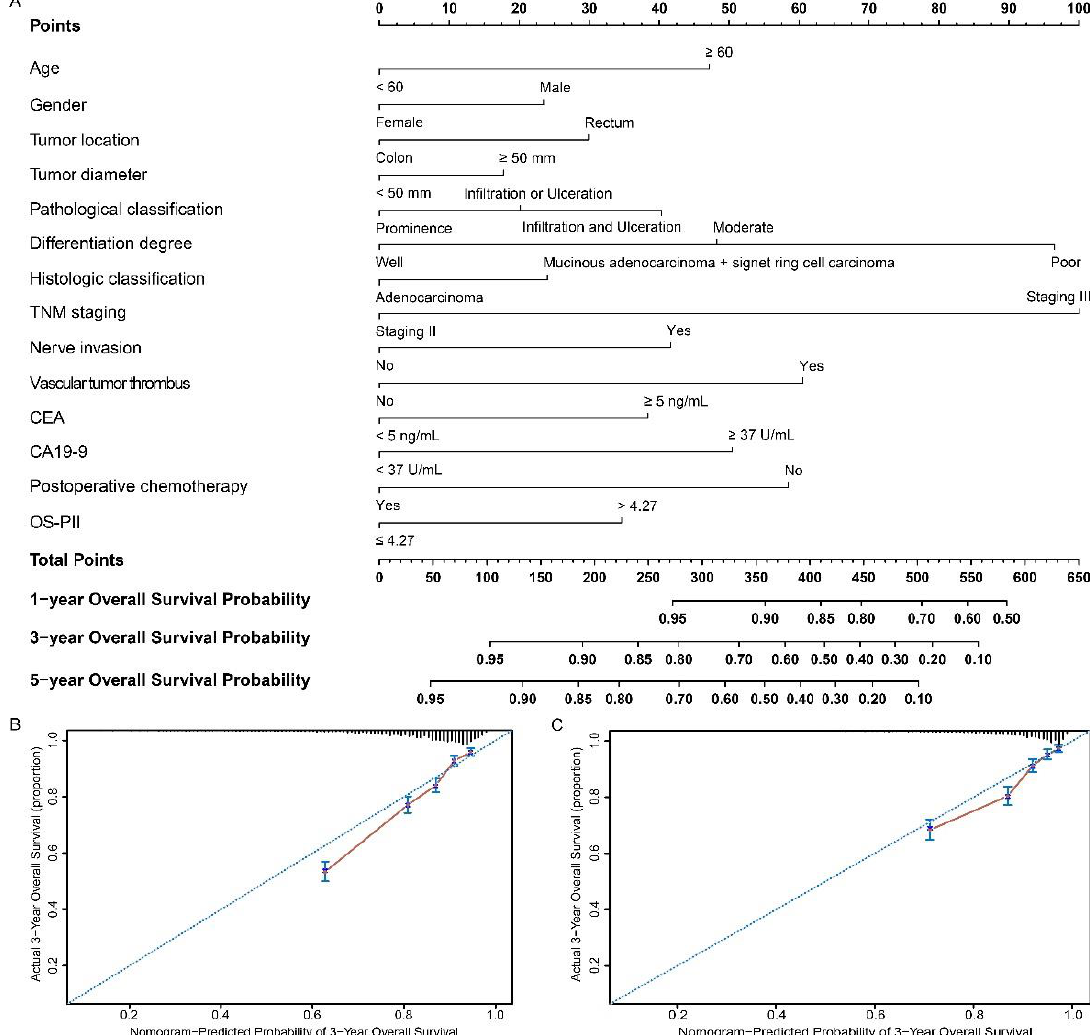
Figure 4. Nomograms to predict overall survival in patients with CRC. Nomograms were performed by using clinicopathological characteristics and OS-PII to predict overall survival ( A ) and calibration curves of the nomogram to predict overall survival at 3 years in the training cohort ( B ) and the validation cohort ( C ). Nomograms map the predicted probabilities onto points on a scale from 0 to 100 and can be interpreted by accumulating the points that correspond to the predicted probability, which is indicated at the top of scale. The total points were converted to predict 1-, 3- and 5-year probabilities of death and recurrence or metastasis for patients with CRC.